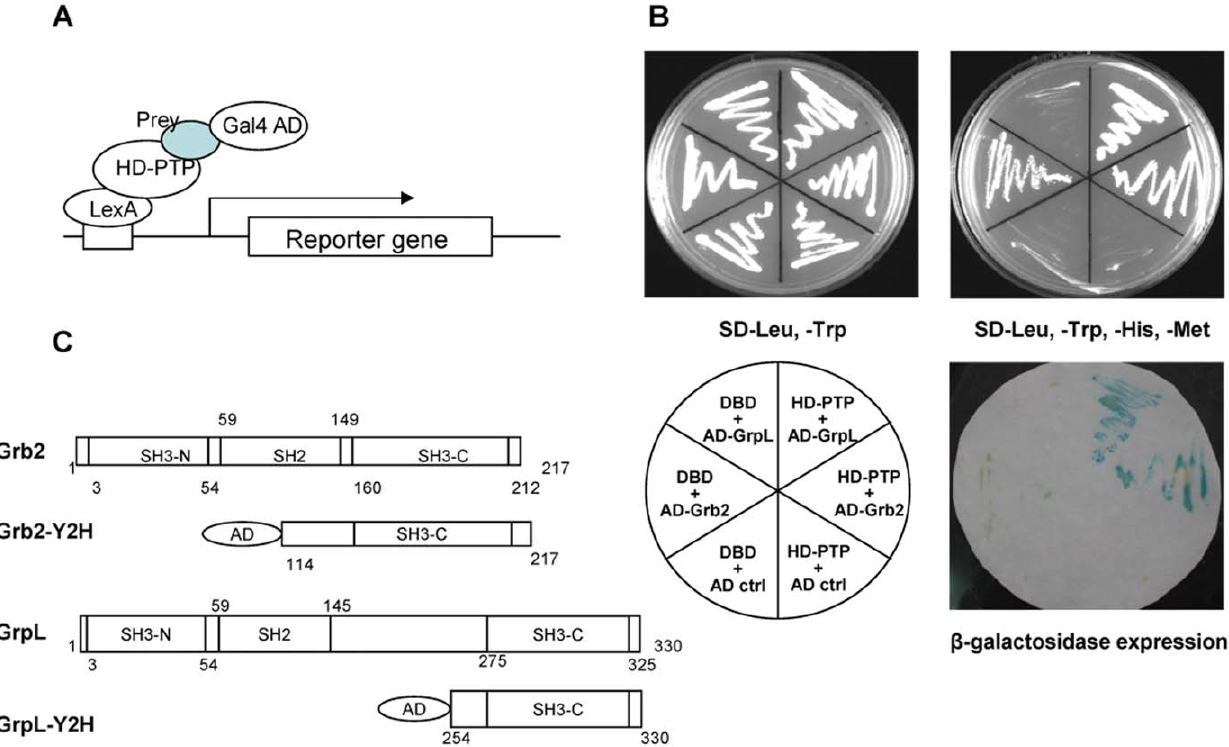
Figure 1. Identification of HD-PTP interaction with GrpL and Grb2 by yeast two-hybrid assay. (A) A scheme of the yeast two-hybrid screen. The binding of the ‘‘prey’’ to the HD-PTP ‘‘bait’’ yields a functional transcription factor that promotes the transcription of the reporter genes. In the absence of an interaction between the ‘‘bait’’ and the ‘‘prey’’ the reporters (e.g., HIS3 and LacZ ) are not induced. (B) Yeast L40 cells were co- transformed with the expression plasmid encoding the full-length HD-PTP fused with LexA DNA-binding domain (DBD, bait) and each expression plasmid encoding either the full length GrpL or the C-terminal half of Grb2 fused with the Gal4 activation domain (AD, prey). Transformants were selected on double dropout (SD-Trp, -Leu) medium plate. Each positive transformant was streaked on double dropout selection medium plate (SD- Trp-Leu) and quadruple dropout (SD-Trp,-Leu,-His,-Met). A filter replica of the SD-Trp,-Leu,-His,-Met plate was used to assay for b -galactosidase activity. Ctrl, empty vectors. (C) Schematic representation of the domain structure of Grb2, GrpL and the two interacting fragments found by the yeast two-hybrid screening.